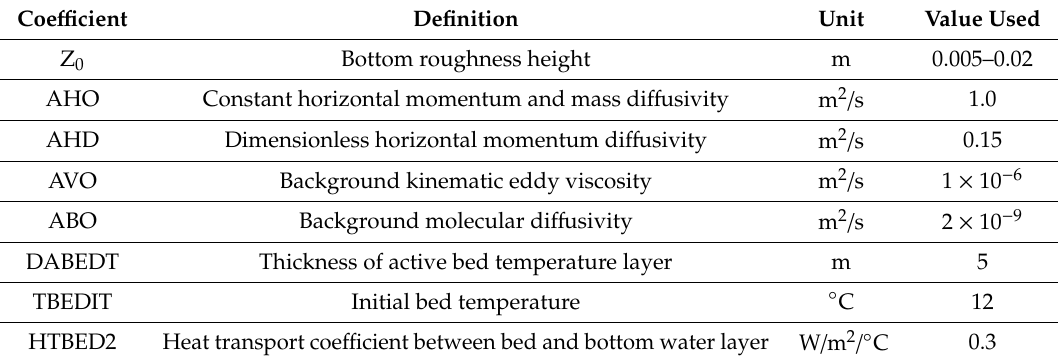
Table 1. Main coe ffi cient for calibration and validation parameters used in the EFDC